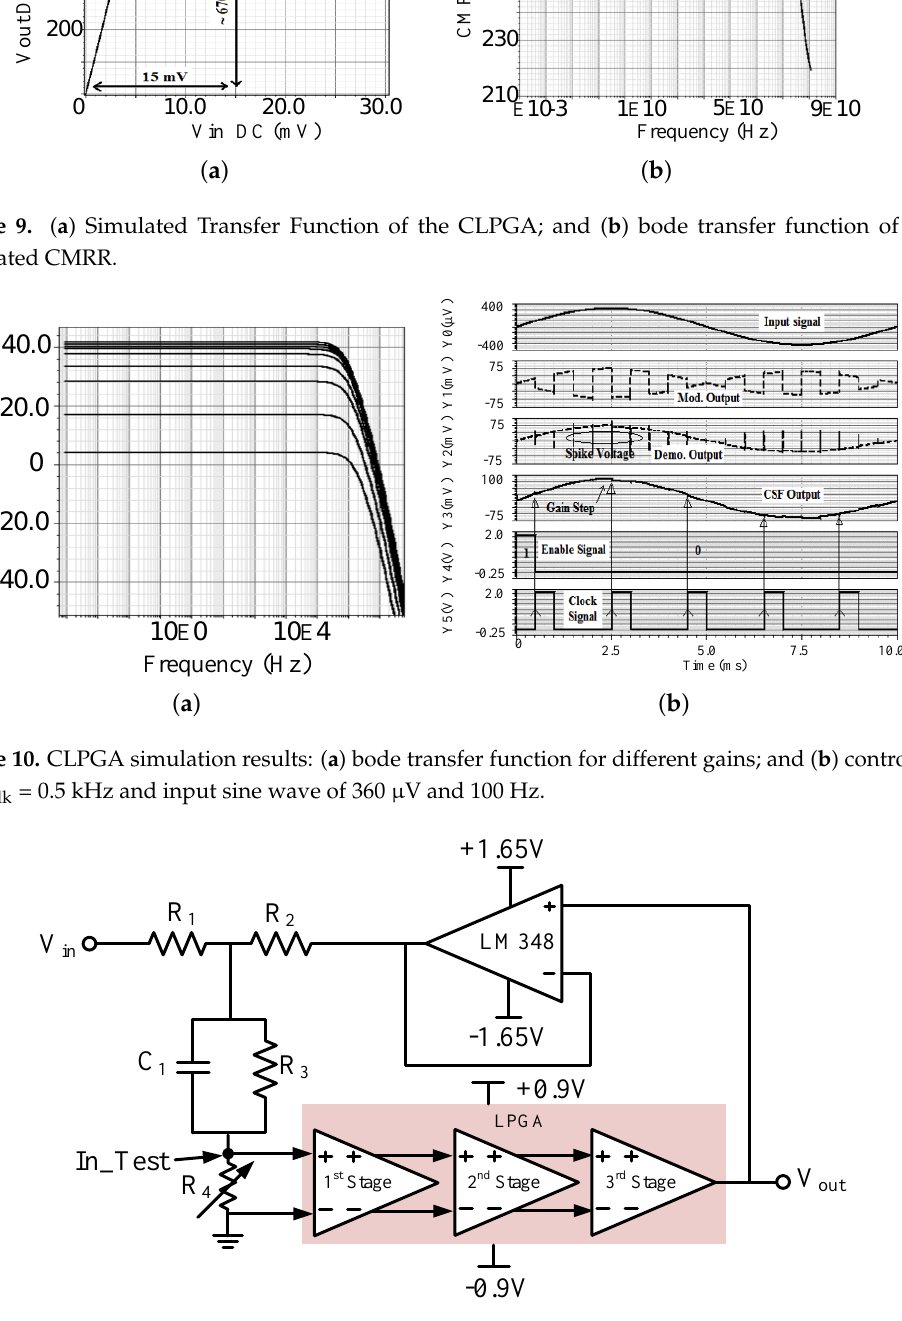
Figure 11. Experimental set-up for LPGA open-loop gain